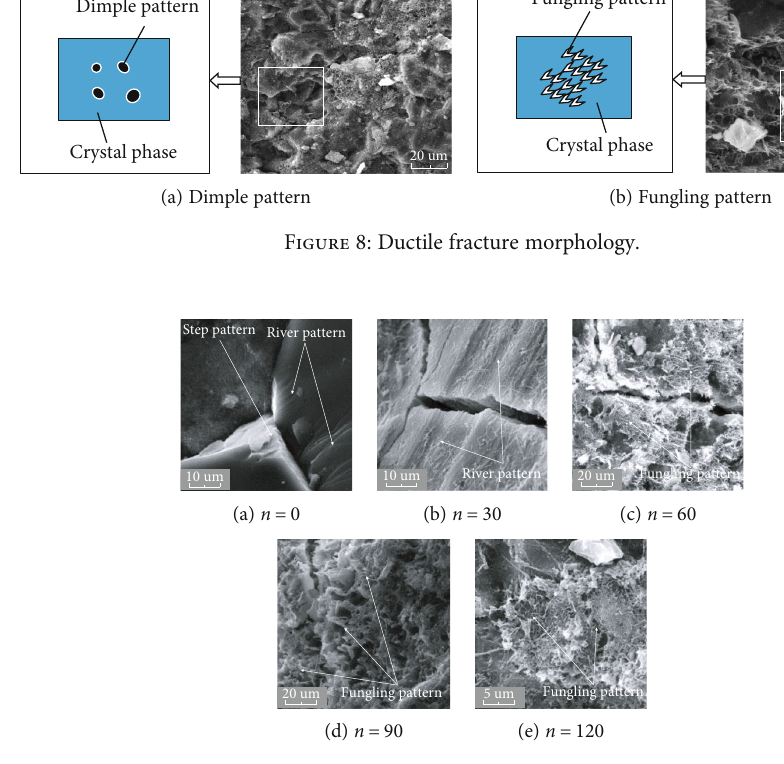
Figure 9: Fracture morphology of concrete after di ff erent freeze-thaw cycles ( m = 35 %